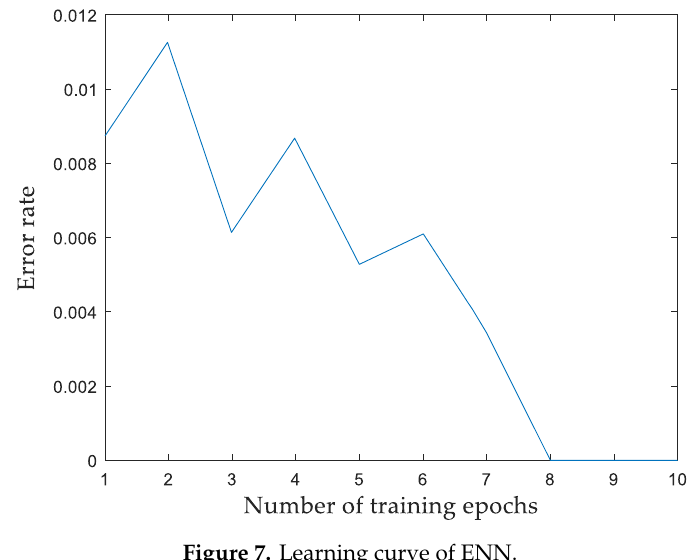
Figure 7. Learning curve of ENN.